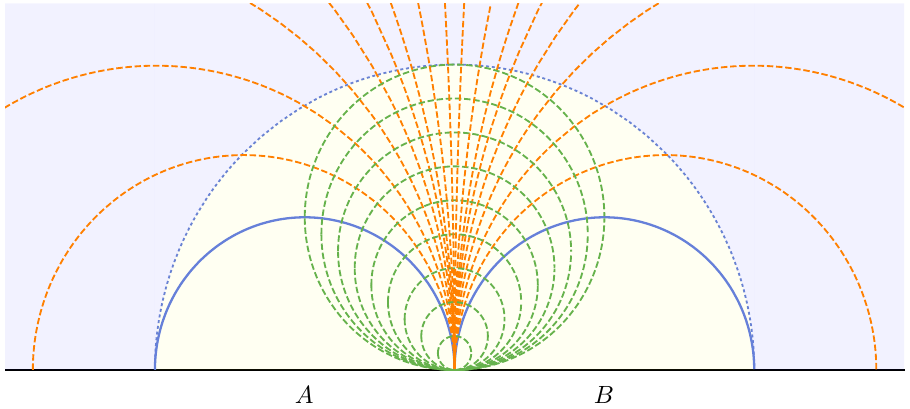
Figure 10 . A graphic illustration of the construction of a maximally packed (cid:13)ow for two adjacent intervals in AdS. The (cid:13)ow is obtained as a speci(cid:12)c limit of the disjoint case, presented in (cid:12)gure 9. All conventions of (cid:12)gure 9 apply to the present one as